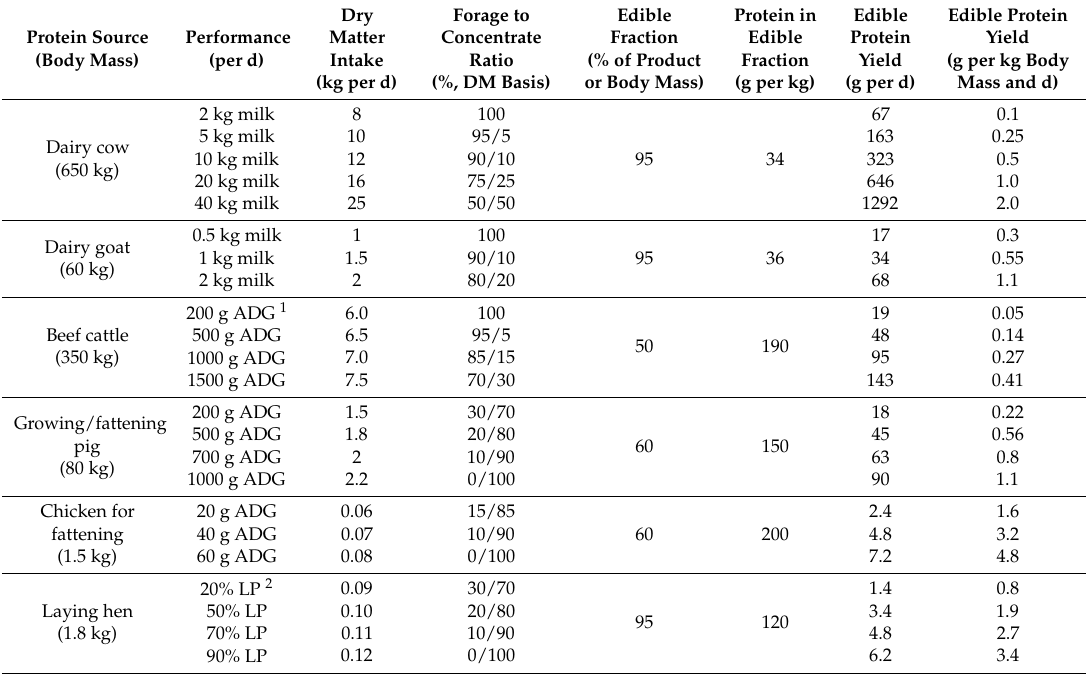
Table 4. Influence of animal species, categories, and performances on yield of edible protein (without considering rearing periods and animal losses)